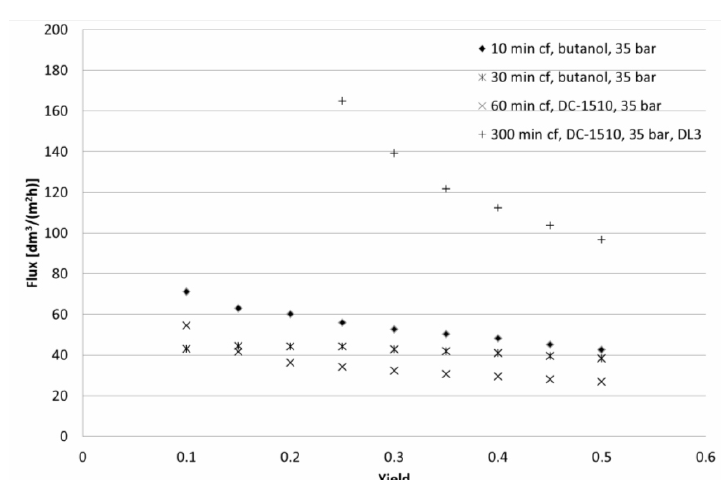
Figure 8. Measured fluxes of nanofiltration at 30 bar at 20°C.